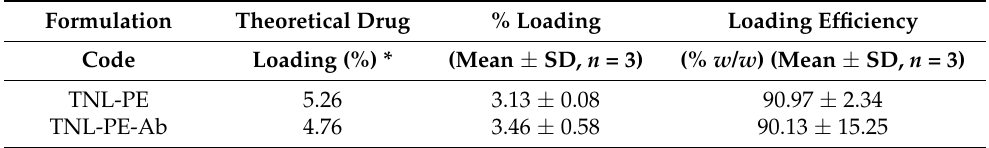
Table 3. Percentage of theoretical drug loading, percentage of practical drug loading and loading efficiency of nanolipid vesicles.